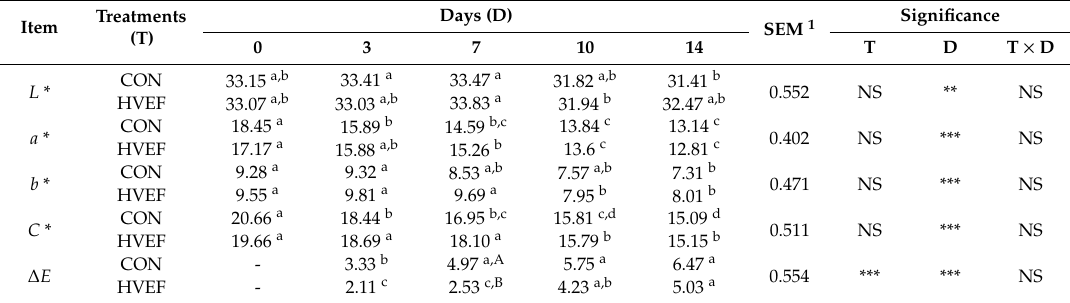
Table 1. Influence of HVEF on color parameters of dry-cured beef during